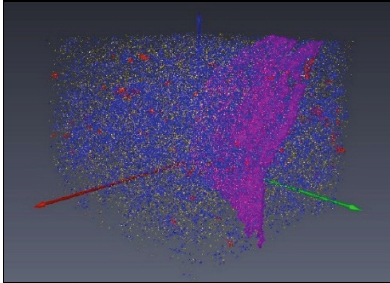
Fig. 6. Microtomographic image of Devonian sandstone pore space (subsample A); Avizo application, OGI-NRI in Cracow